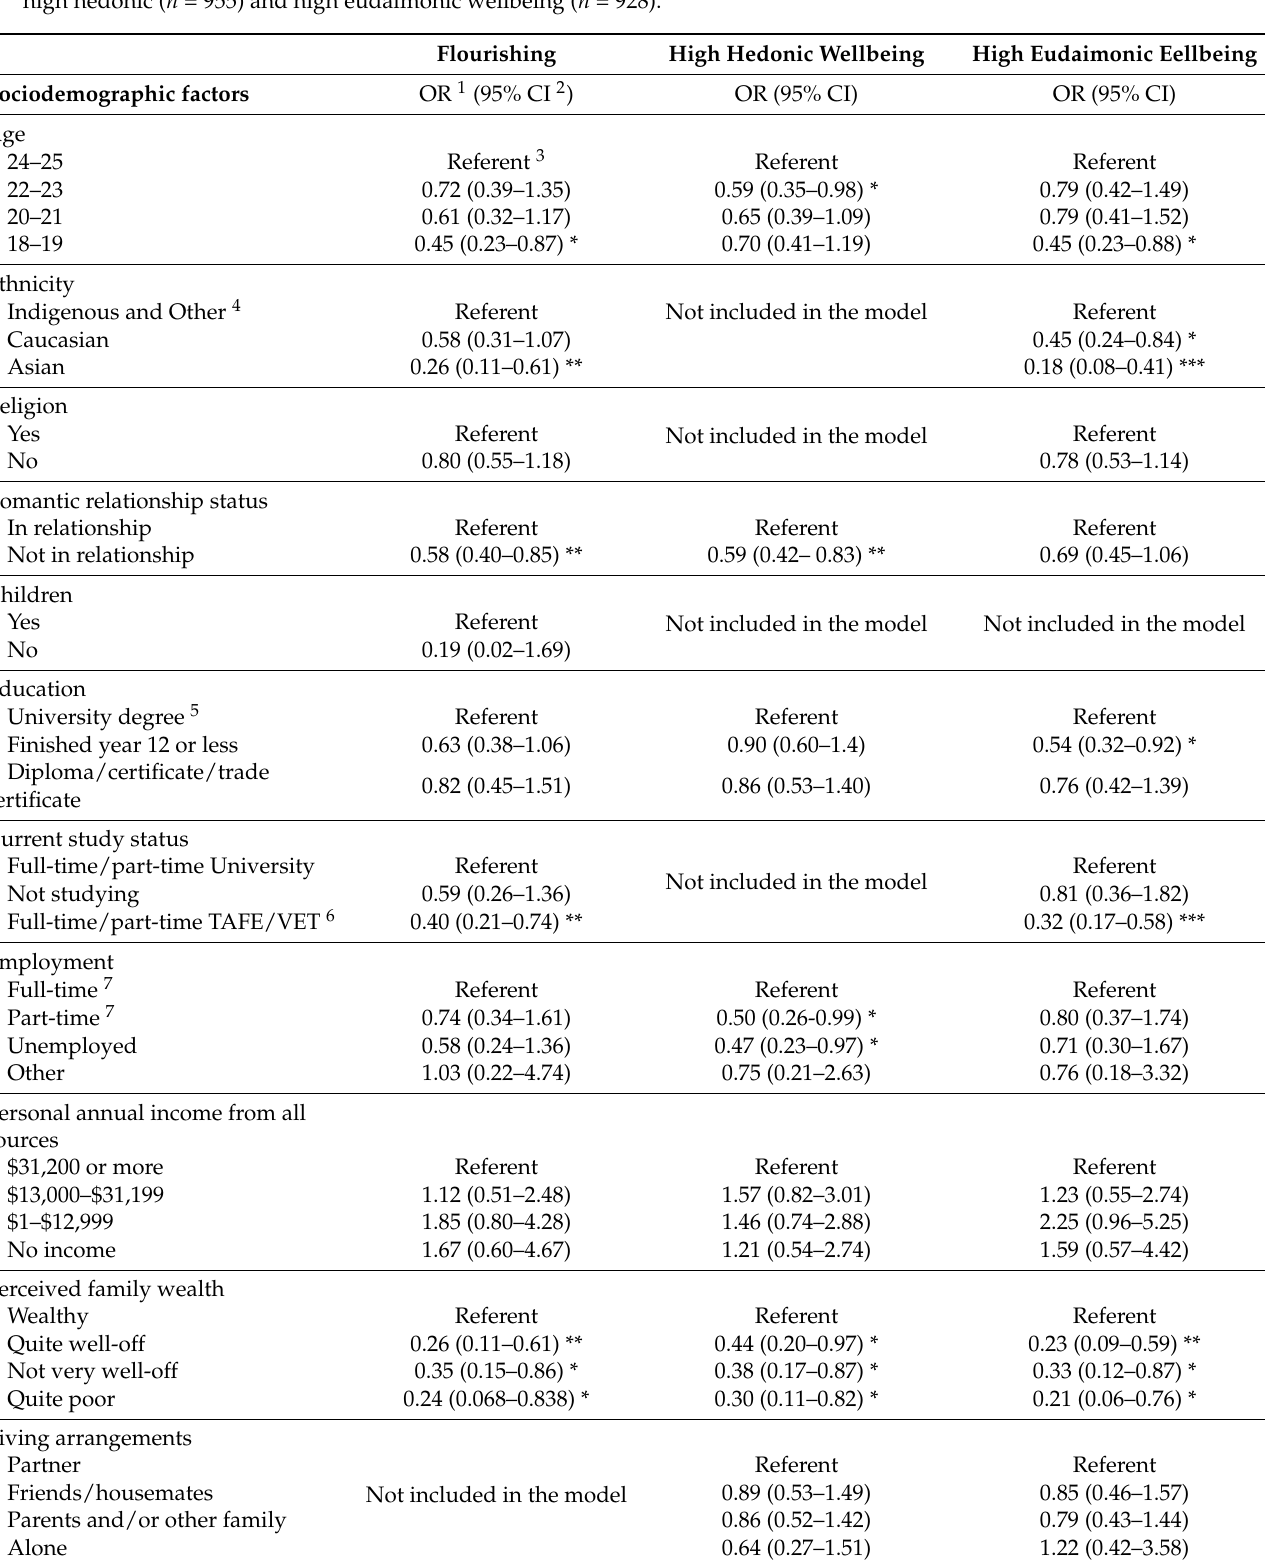
Table 4. Multivariable logistic regression in examining the relationship between study factors and flourishing ( n =